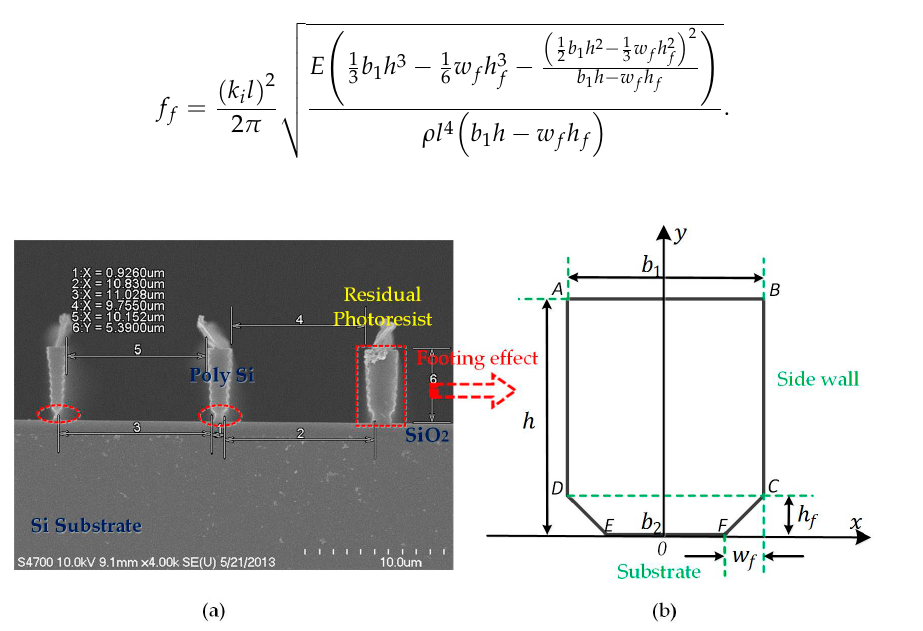
Figure 4. Footing effect of a doubly-clamped beam: ( a ) SEM side-view, fabricated by the Bosch process and un-released; ( b ) the coordinate sketch-map for the structure circled in red in ( a ).